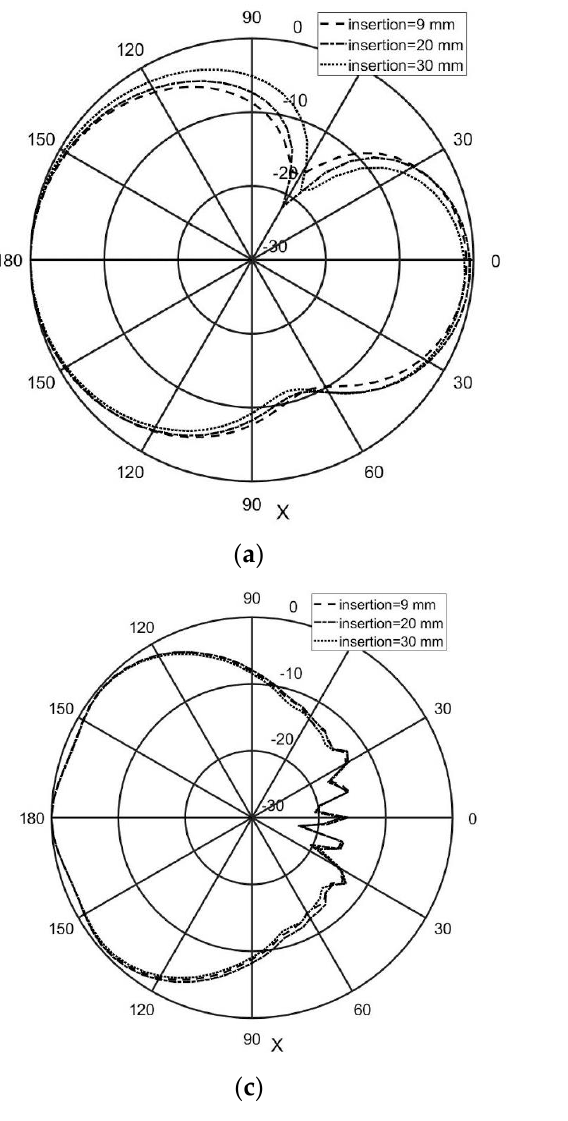
Figure A3. Normalized gain pattern with insertion distance of antenna 2 on the horizontal plane: ( a ) f = 402 MHz, ( b ) f = 868 MHz, ( c ) f = 2.45 GHz and ( d ) f = 5.8 GHz (only two insertion distances are shown as the noise is dominant above 20 mm at this frequency).